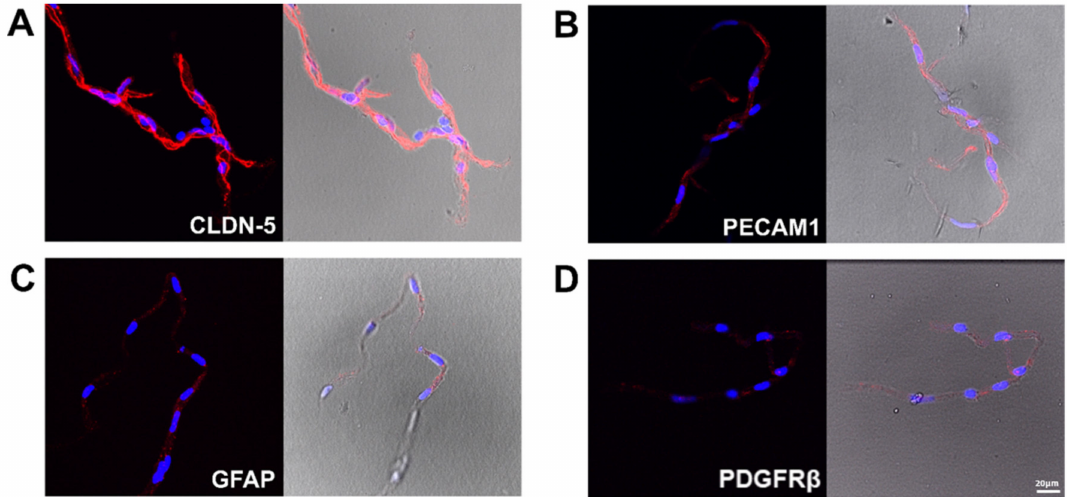
Figure 3. Immunostaining of brain microvessels fractions for markers of neurovascular unit cells presented as red im- munoreactivity for ( A ) CLDN5 (a marker of tight junctions formed by brain endothelial cells), ( B ) PECAM1 (a marker of endothelial cells), ( C ) GFAP (astrocyte marker), and ( D ) PDGFR- β (pericyte marker). Scale bar: 20 µ